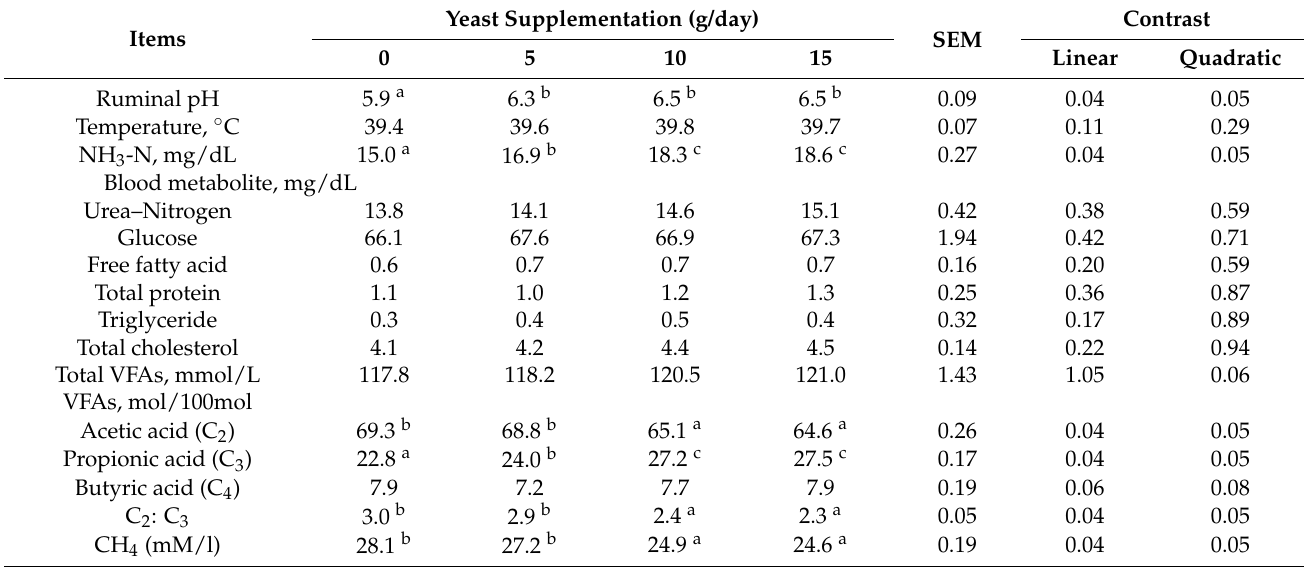
Table 4. Effect of yeast supplementation in high concentrate diet on fermentation characteristics and blood metabolite in fattening